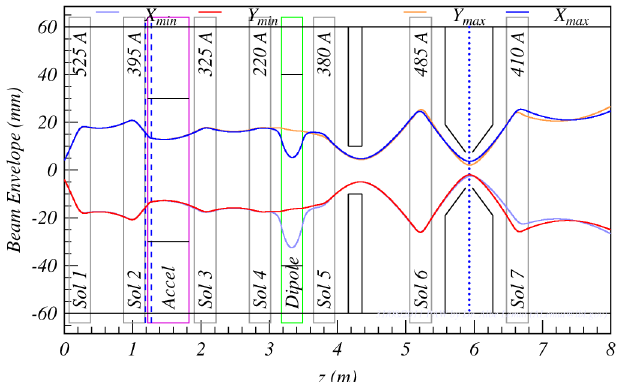
FIG. 9. 4 He þ 60 keV, 50 mA (10 kV postacceleration, 3 kW, gap width 2.6 mm, screening voltage (cid:1) 3 kV , neutralization 90%) beam envelopes through the gas-jet target station beam line. Between the two dashed blue vertical lines the beam is treated at full space charge (length 86.4 mm).